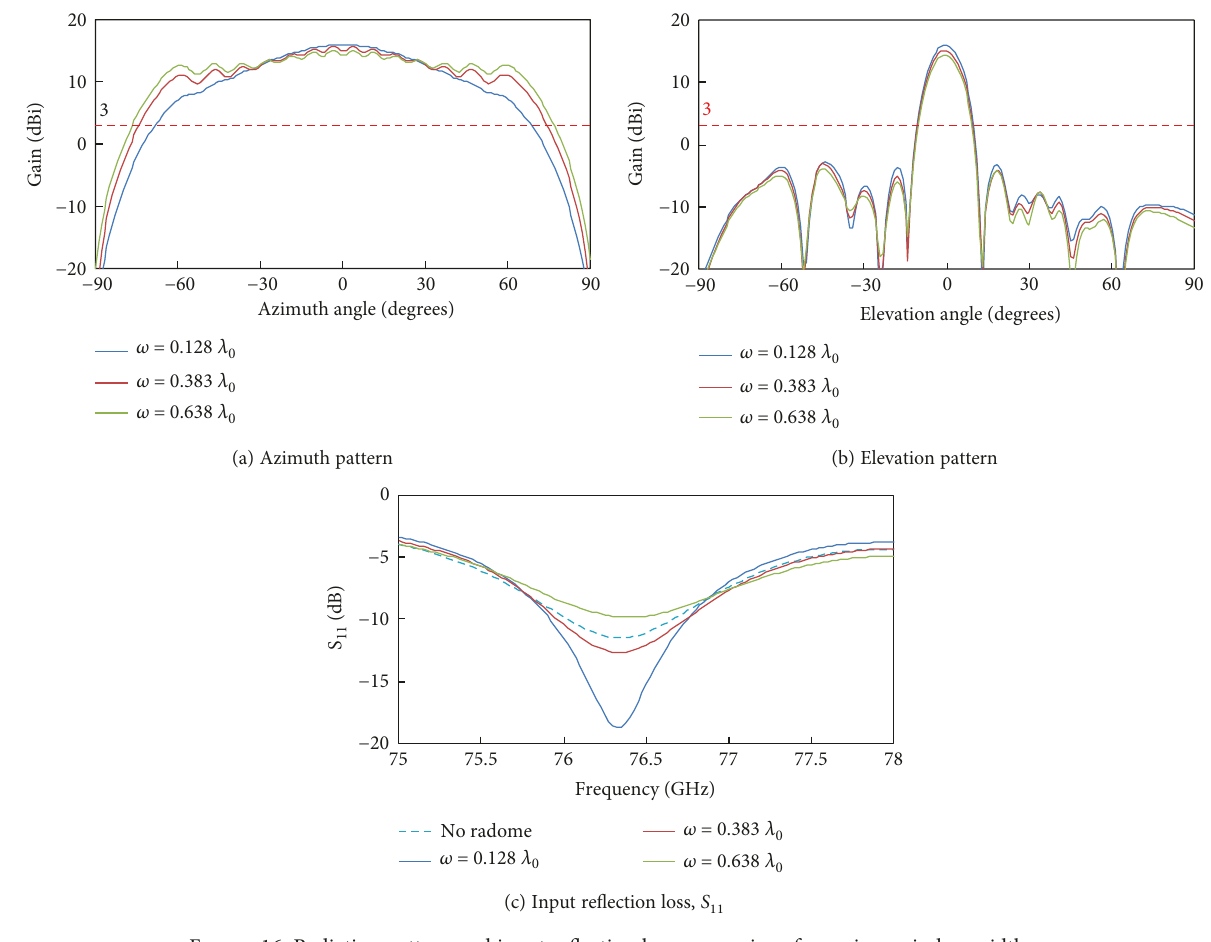
Figure 16: Radiation pattern and input re fl ection loss comparison for various window Table 5: 3dBi beam widths of the defected corrugated radomes with di ff erent ω .